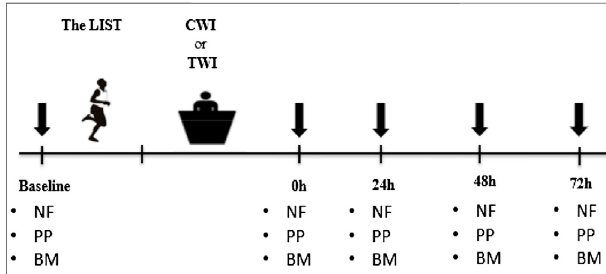
FIGURE 1 | Overview of the entire experimental period. Downward arrowsdenotethetimepointswhenneuromuscular,physicalandbiochemical parameters were recorded. The LIST: Loughborough Intermittent Shuttle Test. CWI: Coldwaterimmersion;TWI: Thermoneutral waterimmersion. NF: Neuromuscular function; PP: Physical performance; BM: Blood